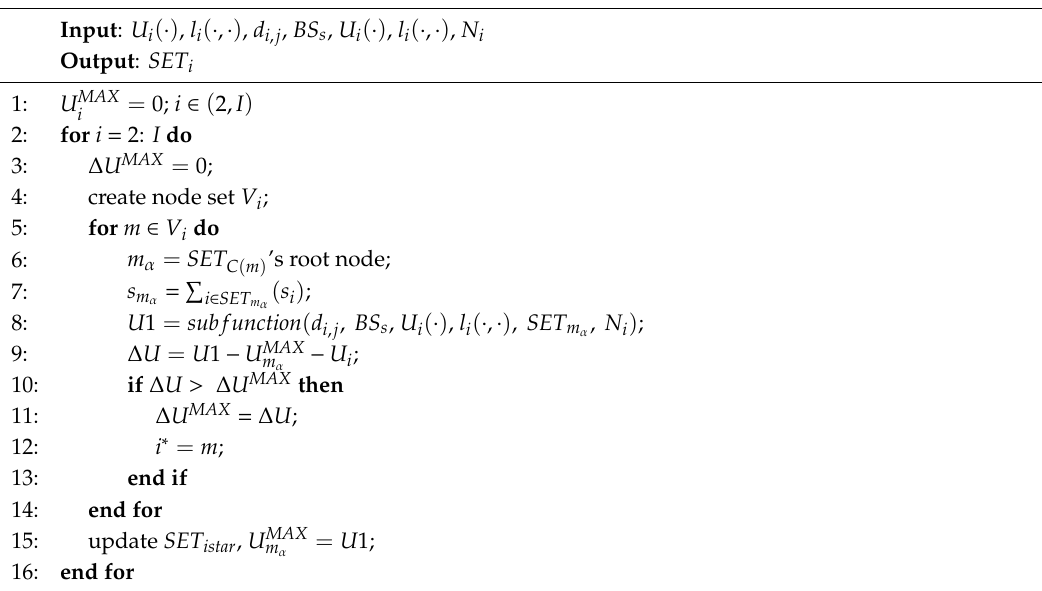
Algorithm 2. Main